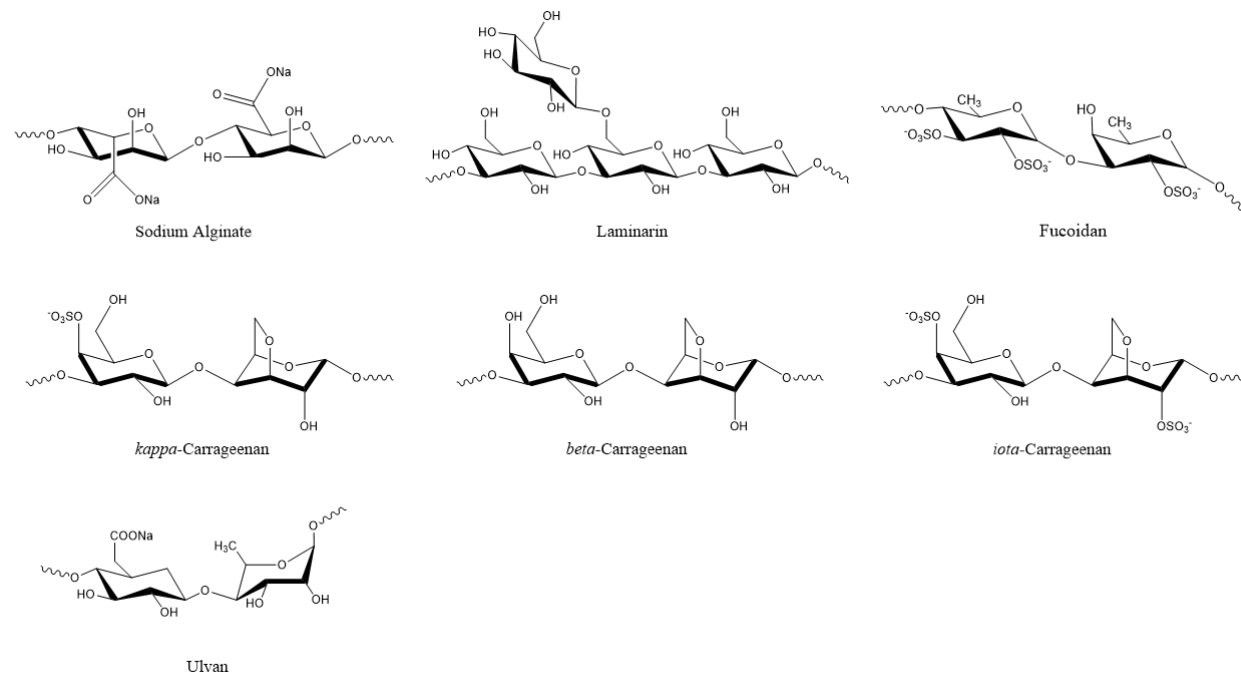
Figure 4. Algal polysaccharides with pesticidal action. Table 2. Summary of the antiviral activities of algal compounds against plant